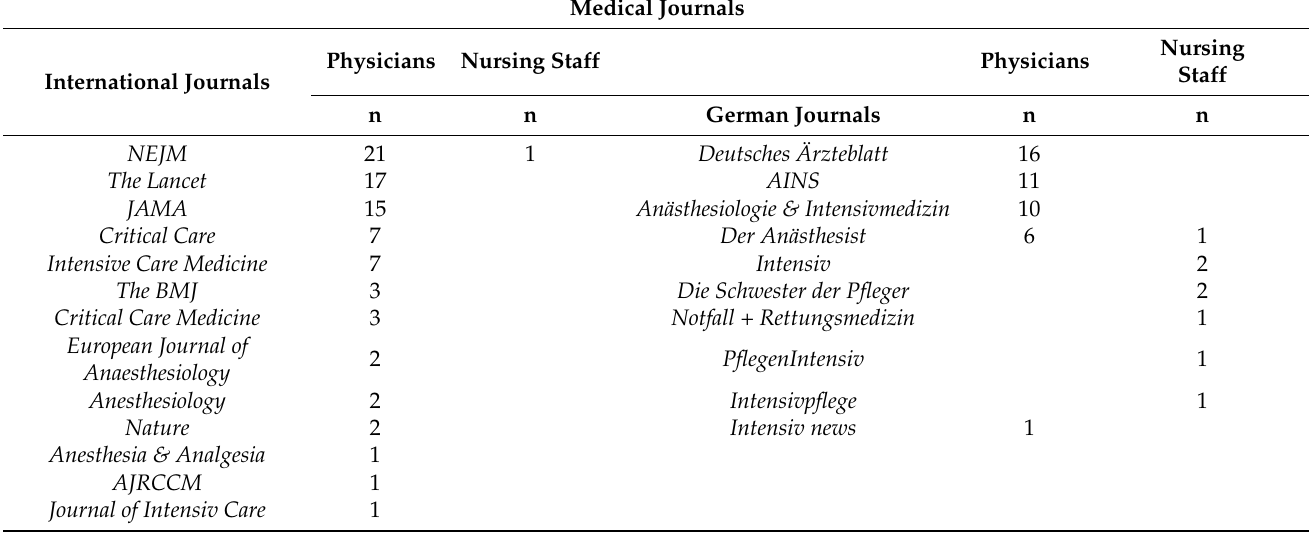
Table 1. Media sources used by participants, summed up free text